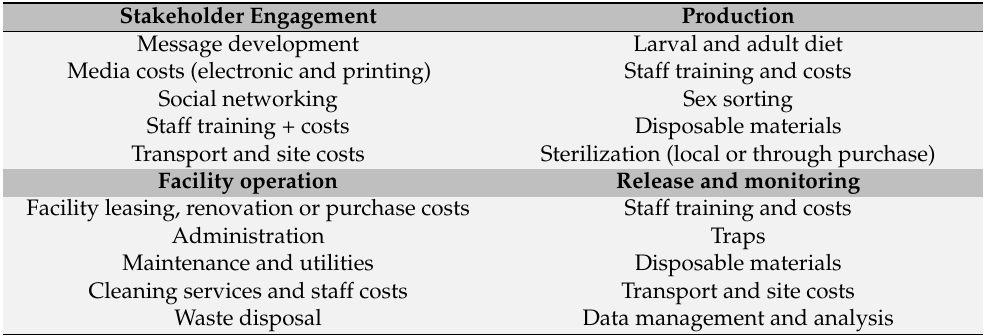
Table 1. Pilot trial sample cost